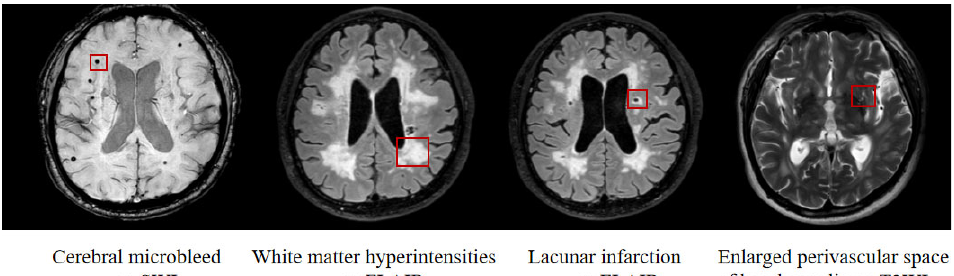
Figure 1. Neuroimaging features of cerebral small vessel disease. From left to right, the images show cerebral microbleed on SWI, white matter hyperintensities on FLAIR, lacunar infarction on FLAIR, and enlarged perivascular space of basal ganglia on T2WI. Abbreviations: SWI: susceptibility weighted imaging; FLAIR: fluid ‐ attenuated inversion recovery imaging; T2WI: T2 ‐ weighted imag ‐ ing.